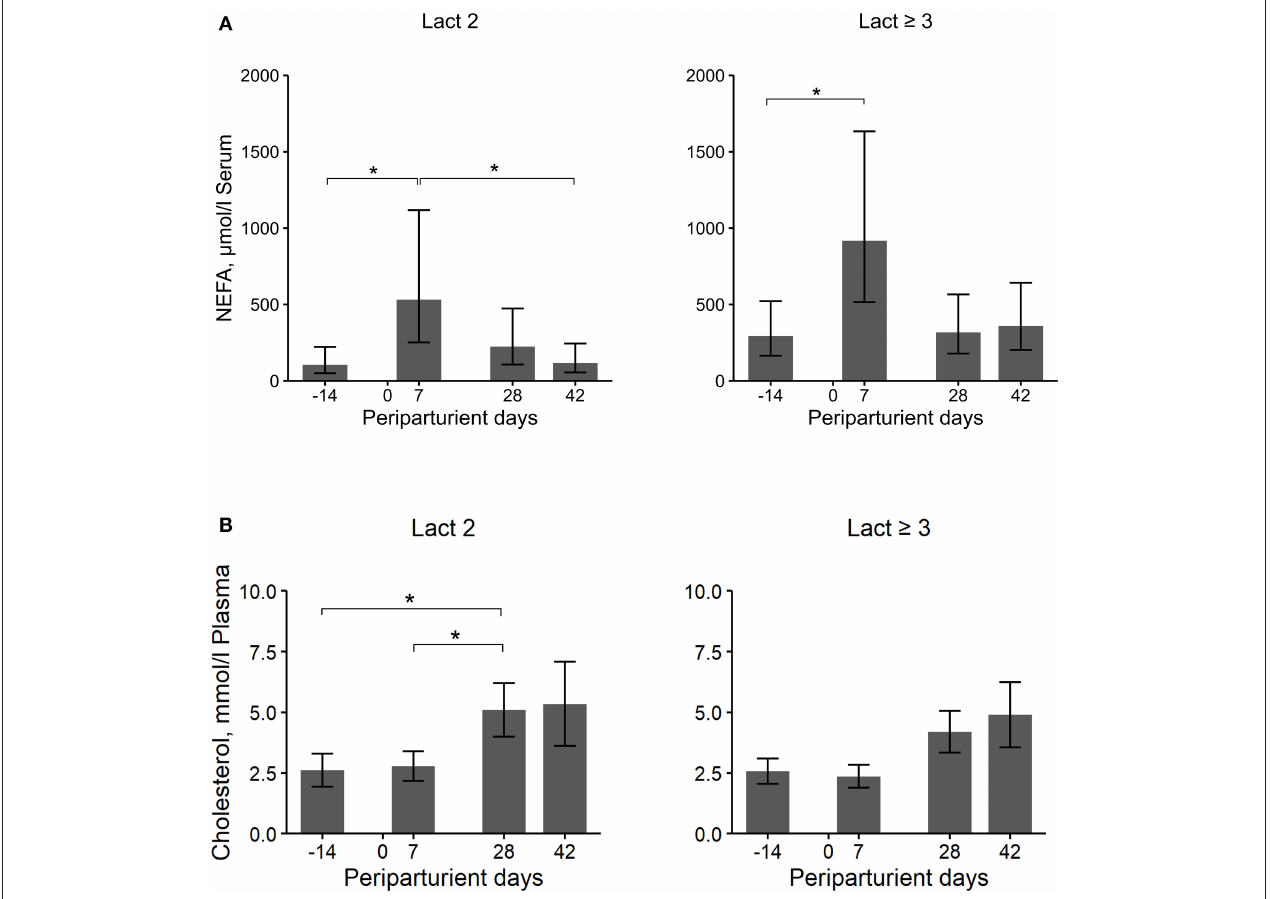
FIGURE 3 | Least square means (LSM) and 95% confidence intervals (error bars) for the NEFA serum (A) and cholesterol plasma (B) concentration at four periparturient sampling days [ − 14 = d 14 antepartum (a.p.); 0 = parturition; 7, 28, 42 = d 7, d 28, d 42 postpartum (p.p.)] in two groups (Lact2 = lactation 2. n = 3; Lact ≥ 3 = lactation 3 or greater, n = 5) of German Holstein cows. Significances between sampling days within groups ( P -values F-test): NEFA serum: Lact2: P = 0.02 , Lact ≥ 3: P = 0.04 ; cholesterol plasma: Lact2: P = 0.04 , Lact ≥ 3: P = 0.05 . Significant changes over time are marked with asterisks (* P < 0.05